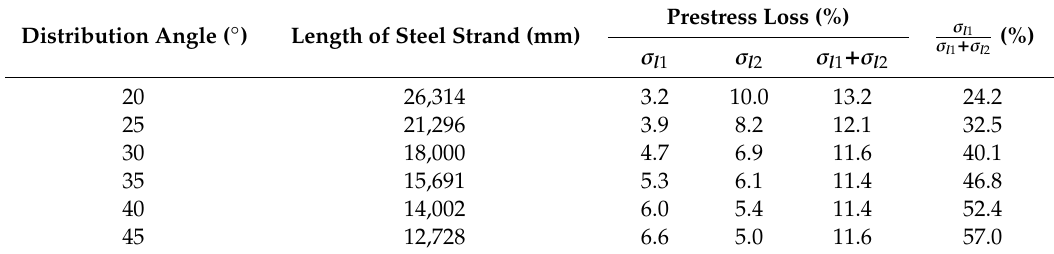
Table 10. Theoretical prestress loss of steel strands given the slab width of 9.0 m. Distribution Angle ( ◦ )